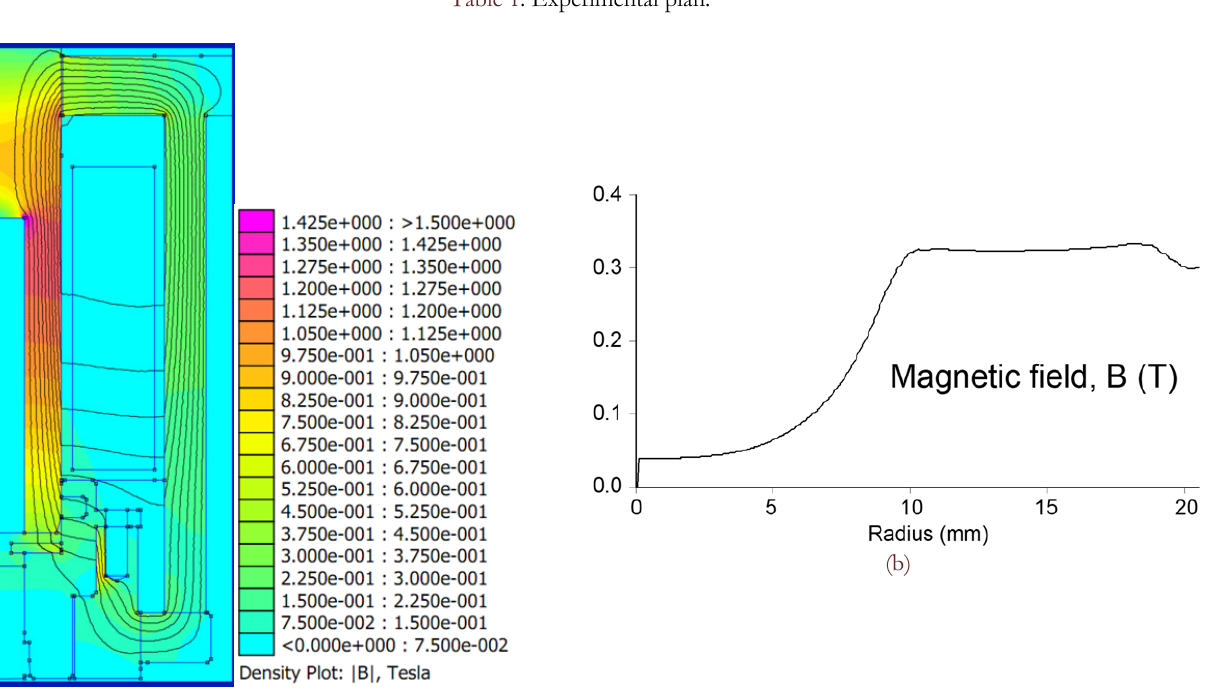
Table 1: Experimental plan.